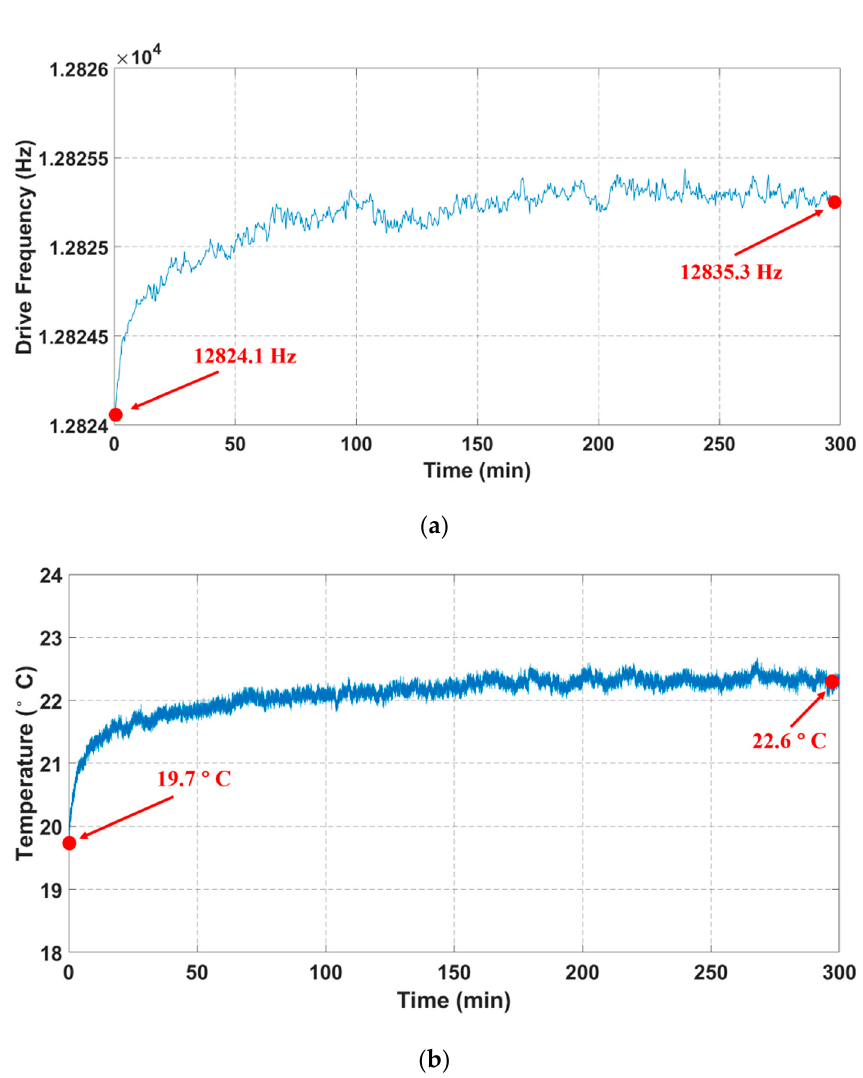
Figure 11. Synchronous sampling results for: ( a ) drive frequencies and ( b ) device temperatures of TFGs.